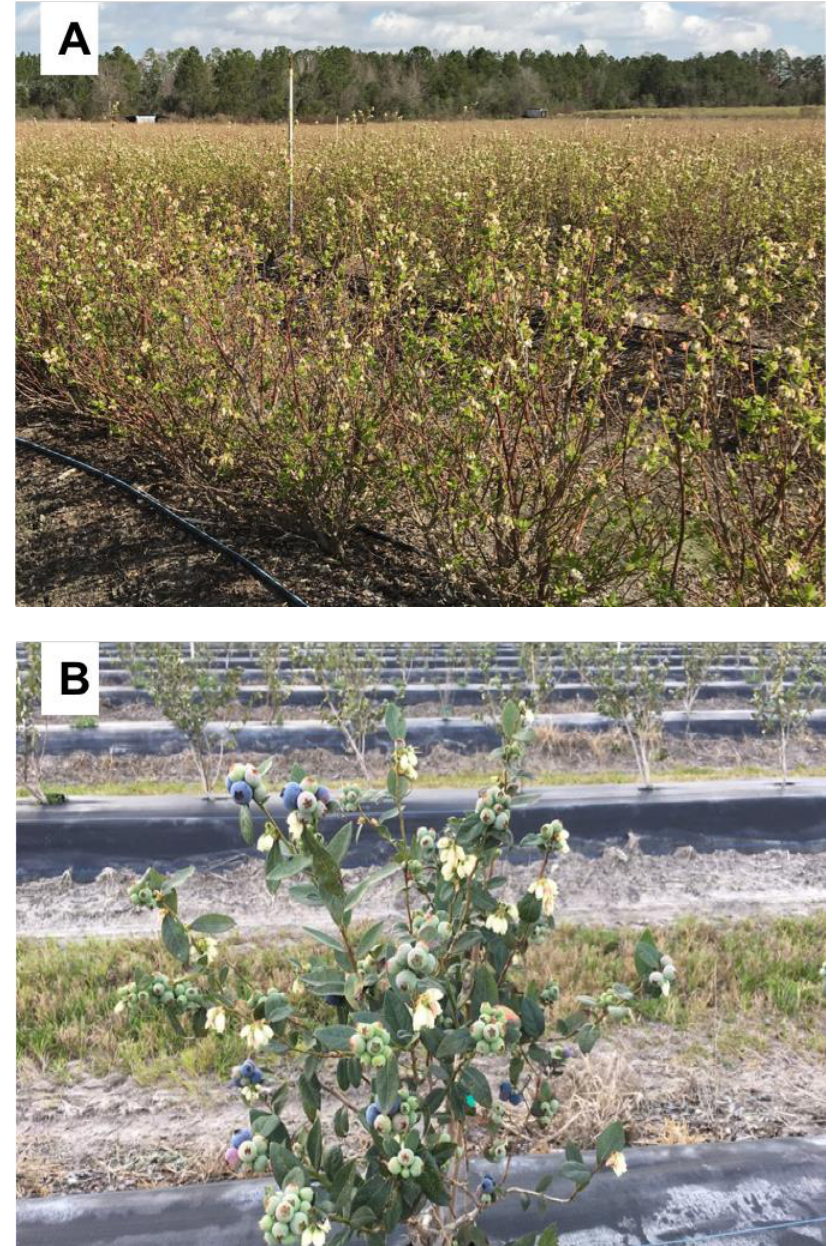
Figure 5. Southern highbush blueberry plants in February 2018 flowering in deciduous system ( A ), while carrying ripe berries in evergreen system ( B ).